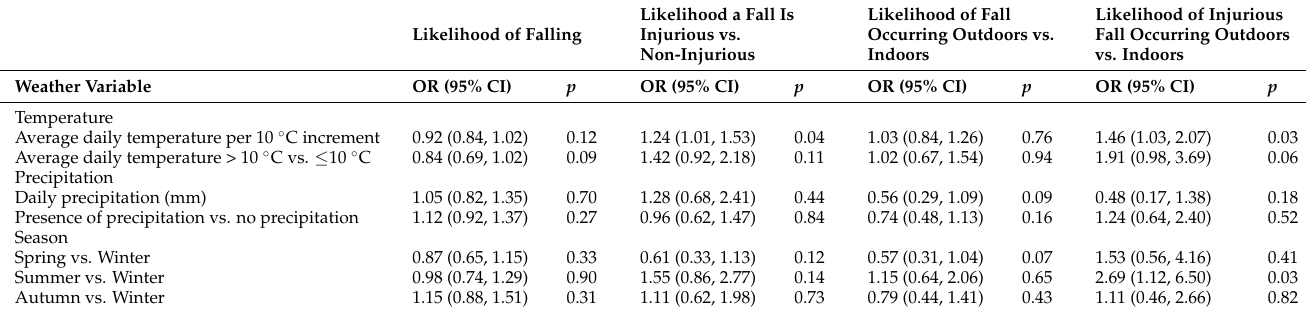
Table 2. Association of weather and season variables with likelihood and location of falls and injurious falls (N = 240) 1